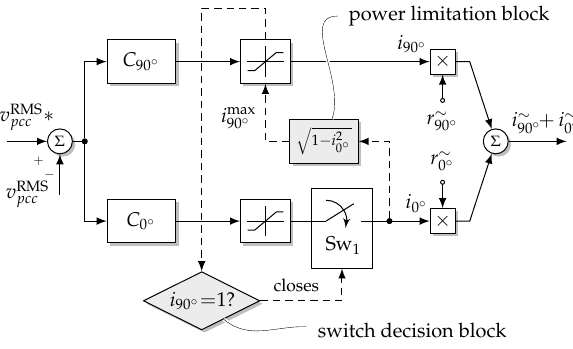
Figure 8. Logic algorithm used within outer control loop for voltage